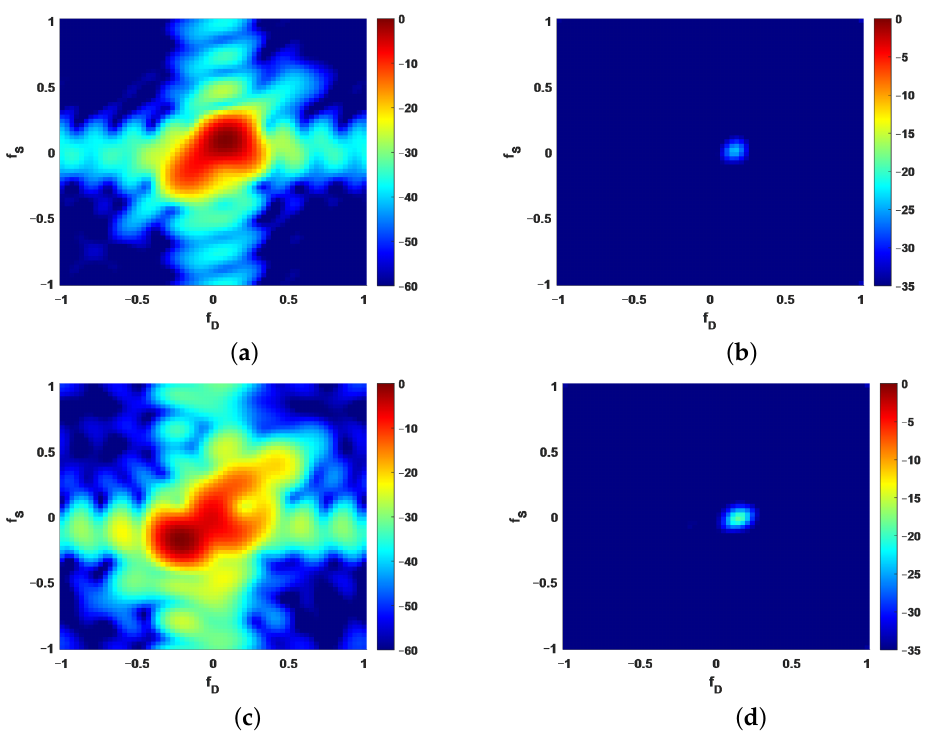
Figure 6. Processing results of different clutter environments with SCR = − 15 dB in the case where the target and clutter are indistinguishable. ( a , b ) ideal case; ( c , d ) non-ideal